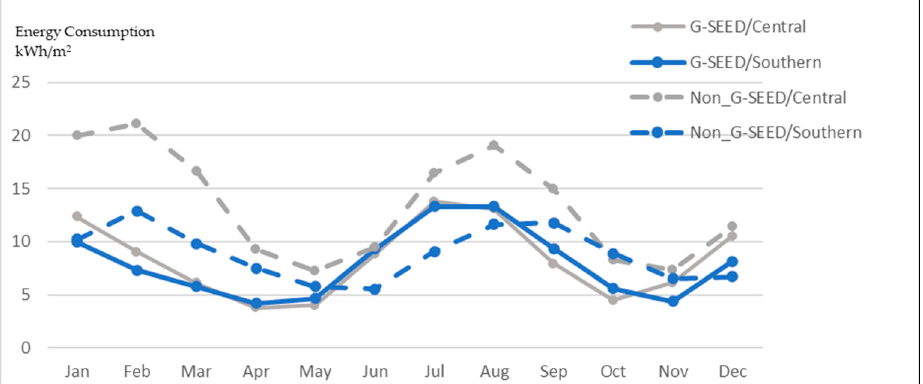
Figure 5. Line chart of the energy consumption of the courthouse buildings based on region and G-SEED